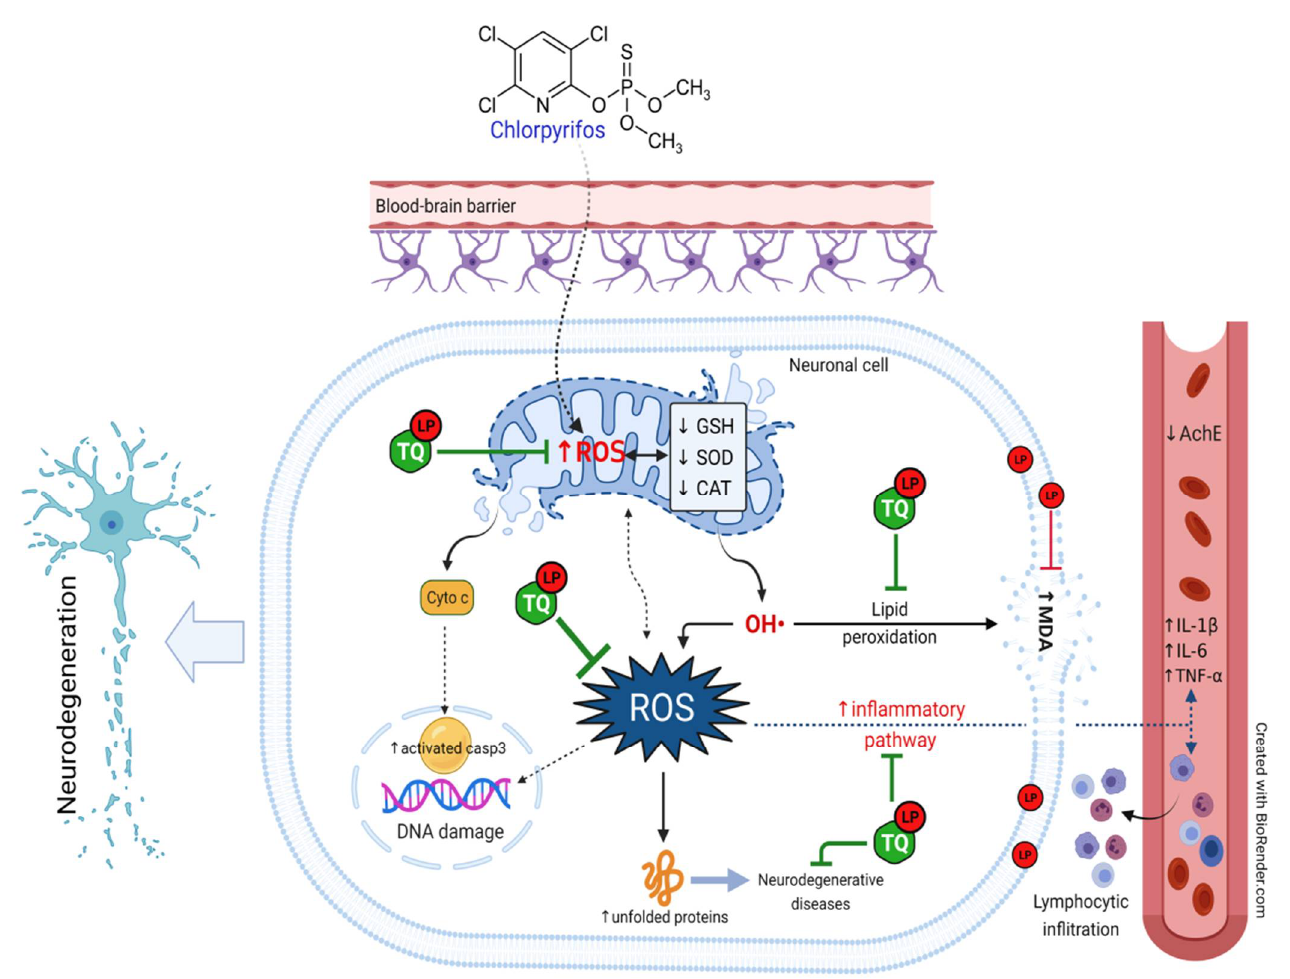
Figure 7. Schematic diagram summarizes the mechanistic insights behinds the protective potential of TQ and LP during CPF-induced neurotoxicity. AchE, acetylcholinesterase; CAT, catalase; CPF, chlorpyrifos; GSH, reduced glutathione; IL- 6, interleukin-6; IL-1 β , interleukin-1 β ; LP, lycopene; MDA, malondialdehyde; ROS, reactive oxygen species; SOD, superoxide dismutase; TNF-α, tumor necrosis factor-α; TQ, thymoquinone.